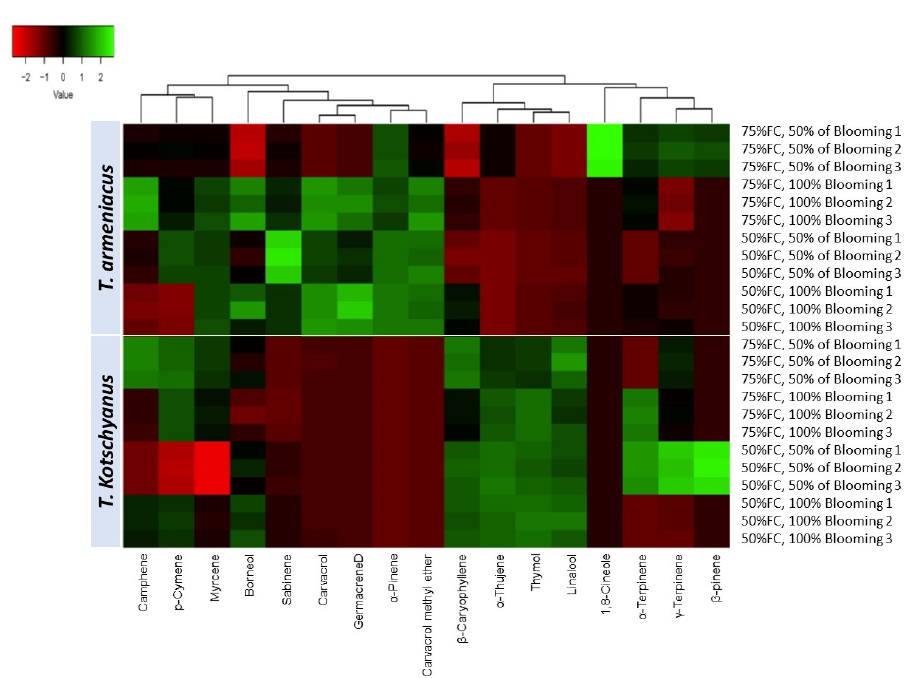
Figure 1. Heatmap of standardized values indicating percentages of essential oil components across treatments. The effect of irrigation regime (75 or 50% of field capacity) on essential oil composition of two Thymus species ( T. armeniacus , T. kotschyanus ) was investigated at two developmental stages (50 and 100% blooming). Essential oil composition is presented in Table 5. Color may indicate up- or downregulation (green and red, respectively). A scale of intensity is provided.